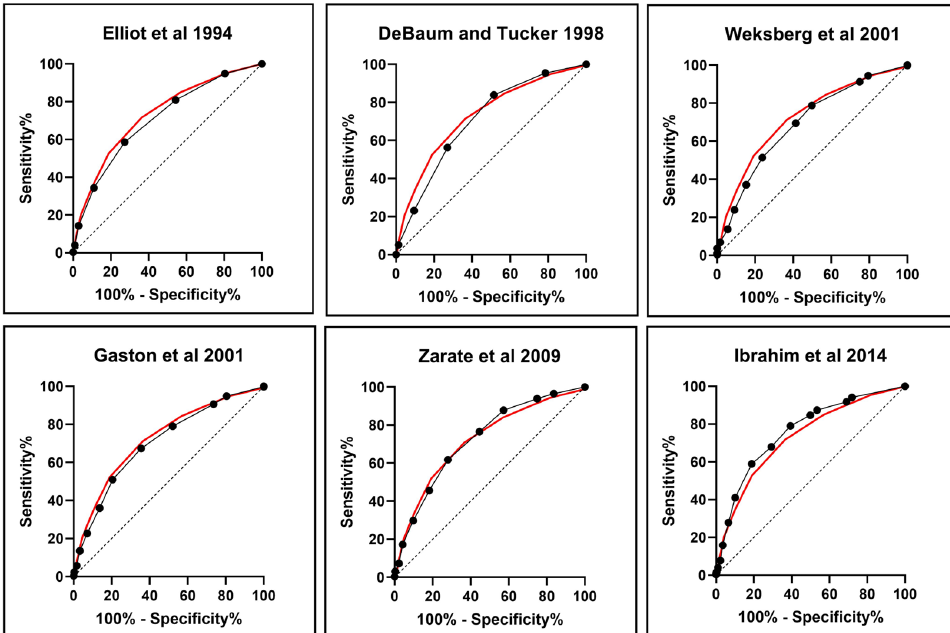
Figure 4. Receiver Operating Characteristic (ROC) curves of the several scoring systems for BWSp proposed over time, evaluated against the outcomes of the molecular tests [2,3,10,14 ‐ 17]. Each of the ROC curves of the various scoring system (in black) is compared with the ROC curve of the consensus criteria by Brioude et al. 2018 [10] (red line). The ROC curve characteristics, area under the curve (AUC), standard error (st.Err), 95% Confidence Interval (95%CI), and p ‐ value are given in Table 4. Performance metrics and characteristics of the several scoring systems for BWSp proposed over time evaluated against the outcomes a) molecular test and b) cancer development: area under the curve (AUC), standard error (st.Err), 95% Confidence Interval (95%CI), p ‐ value, sensitivity (Se),